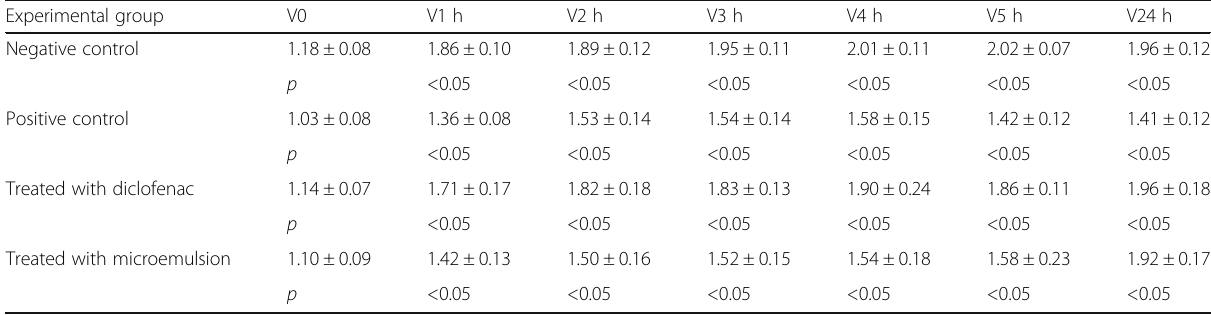
Table 8 The results of the plethysmometric measurement of the paw oedema induced with kaolin, including statistical interpretation (V, the volume of oedema, mL; t Test, p) Experimental